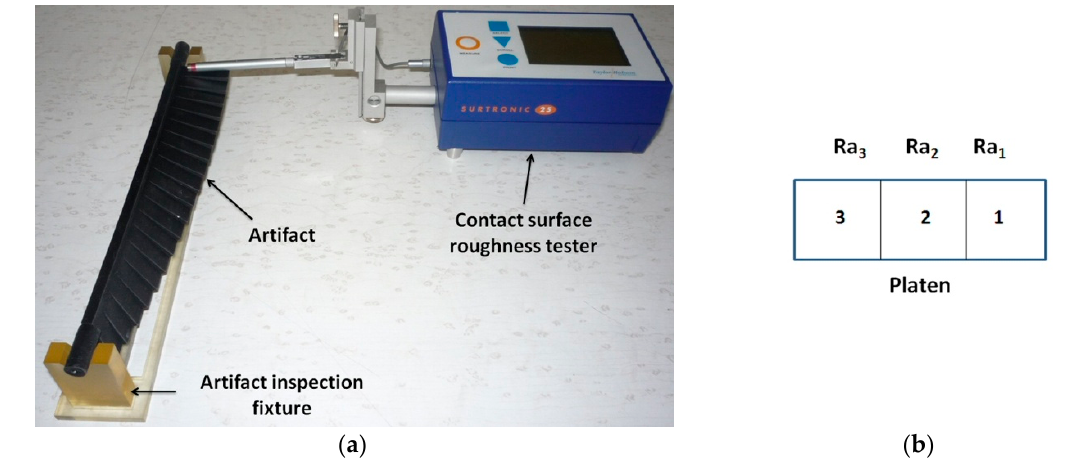
Figure 9. ( a ) Surface roughness measurement of the up-facing surfaces; ( b ) details of the measurement